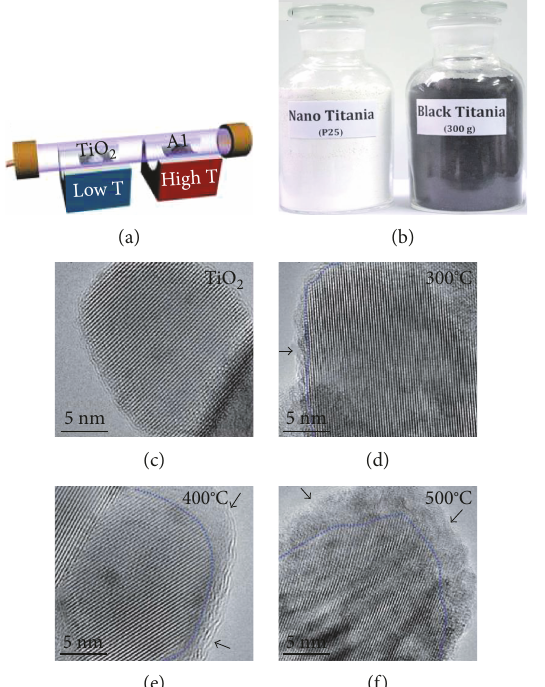
Figure 8: (a) Schematic low-temperature reduction of TiO images of TiO nanocrystals before (c) and after (d – f) the Al reduction at di ff erent temperatures for 6h. Reprinted with permission from [32]. 2 Copyright (2013) The Royal Society of